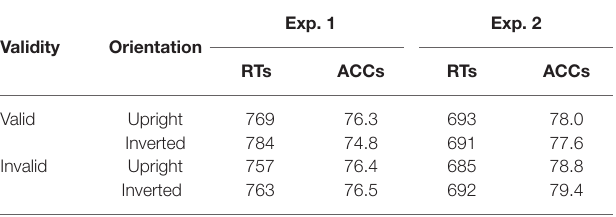
TABLE 3 | Mean reaction times (RTs) in ms and accuracies (ACCs) in % of Experiments 1 and 2 depending on validity and cue